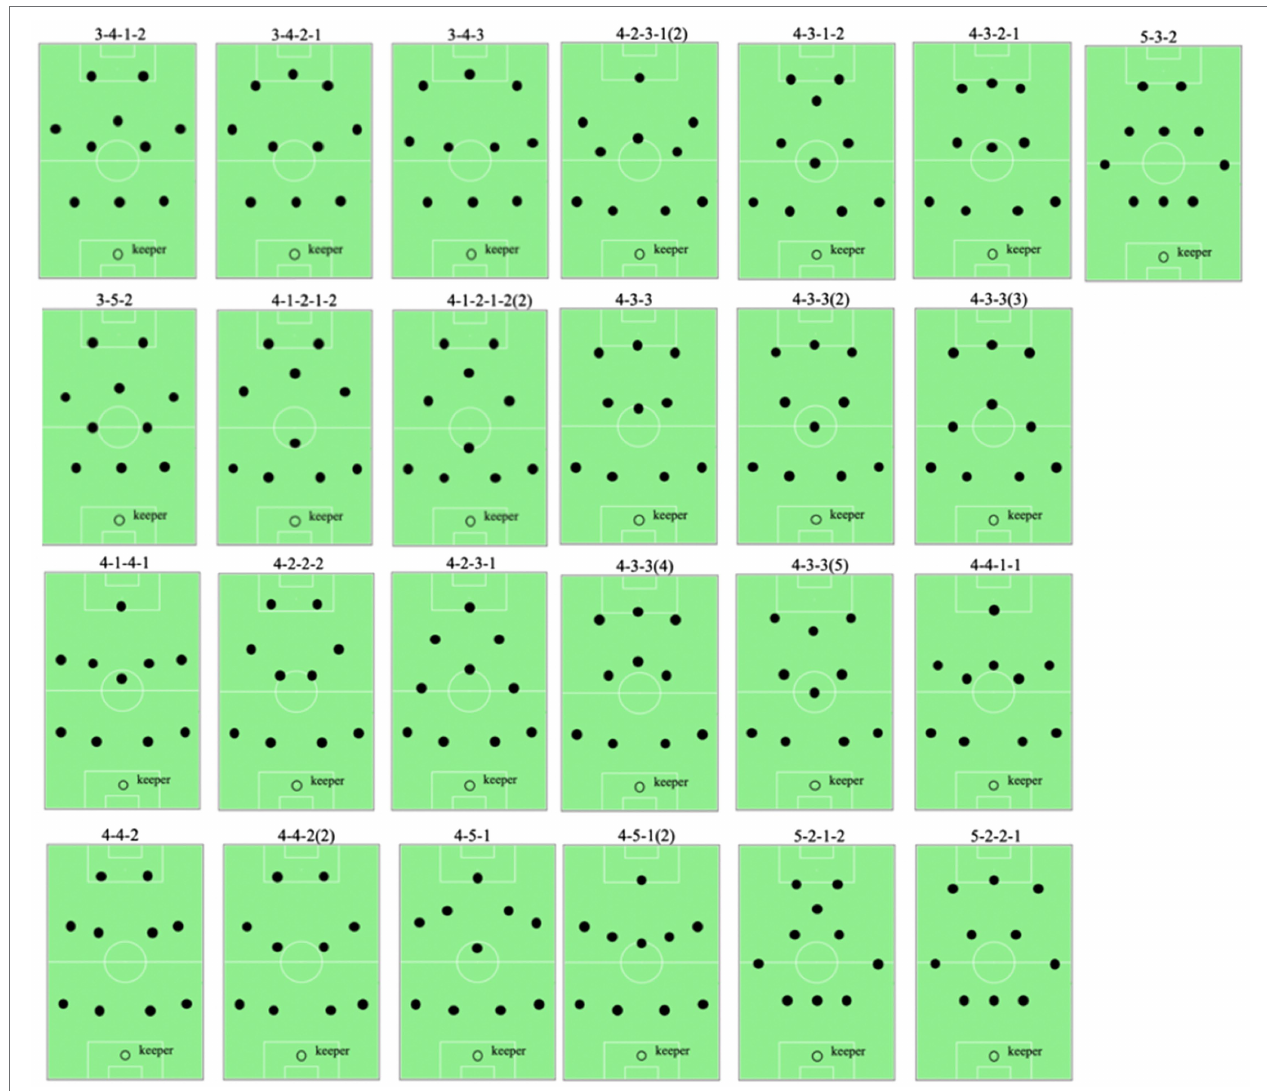
FIGURE 3 | The 25 reference team formations used for the experiment. The data used in this figure were taken from FifaUTeam